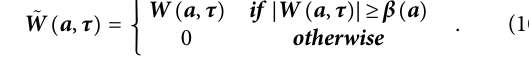
Frontiers in Earth Science |